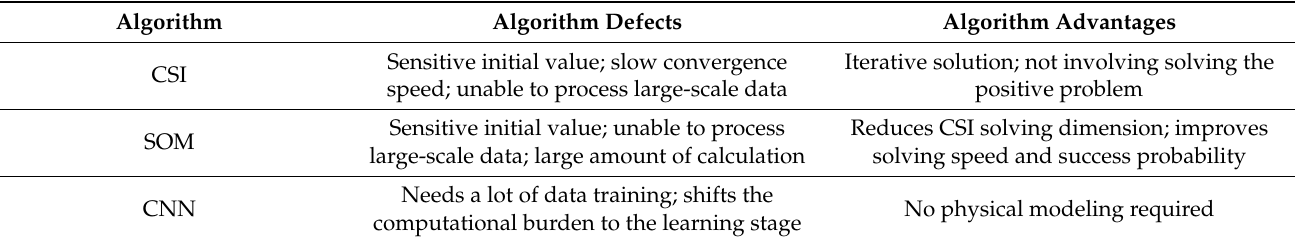
Table 1. Summary of the advantages and disadvantages of algorithms. Algorithm Algorithm Defects Algorithm